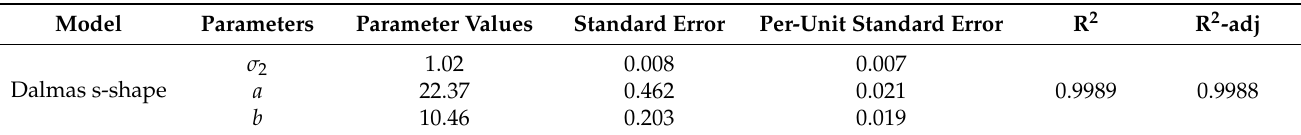
Figure 4. Comparing the Dalmas s-shape model (DsM) with experimental measurement. Table 2. Dalmas s-shape performance